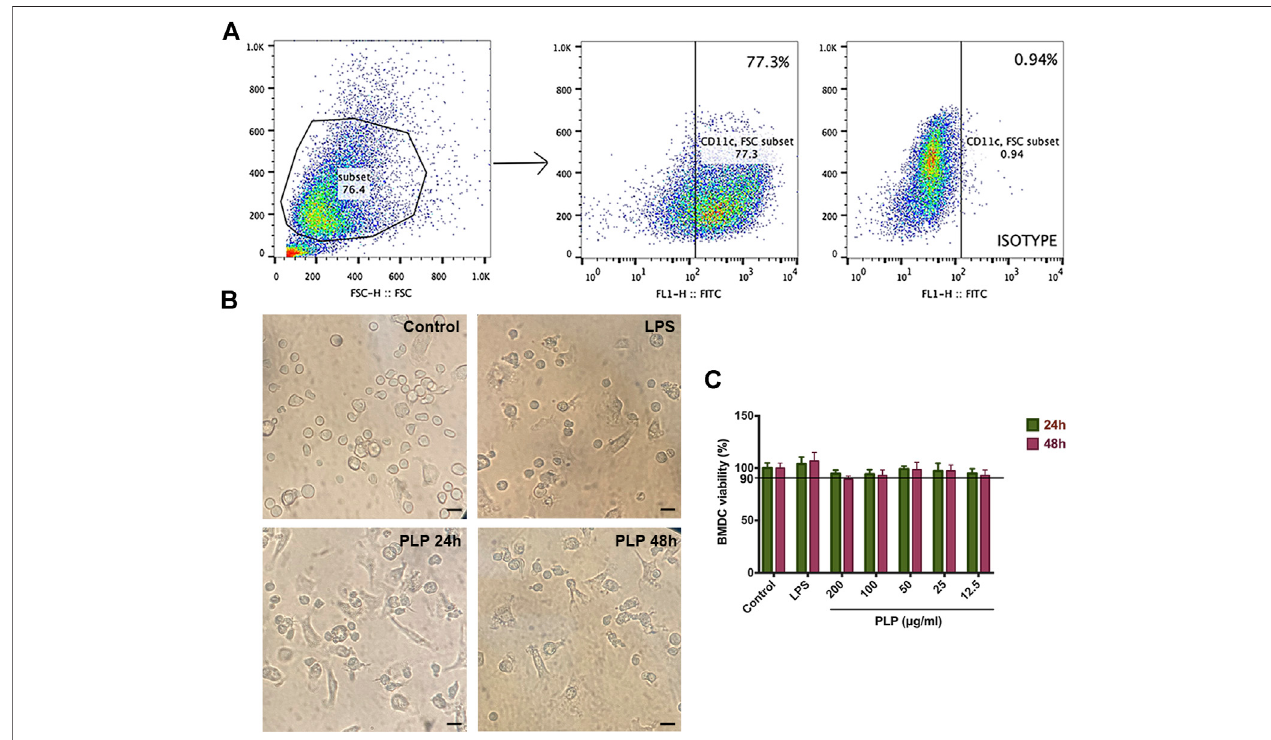
FIGURE 1 | Purity and morphological changes in dendritic cells and cytotoxicity evaluation. (A) Subsets of CD11c + cells were gated. (B) Representative microscopic views of BMDCs maturation stimulated with PLP (50 μ g/ml) and LPS (positive control) for 48 h ( × 100). Bar (cid:2) 150 μ m. (C) Cytotoxic effects of DCs were analyzed using Cell Counting Kit-8 at 12.5, 25, 50, 100, and 200 μ g/ml PLP treatment. Data are shown as mean ± SEM (n (cid:2) 4) (* p < 0.05, ** p < 0.01, and *** p < 0.001).